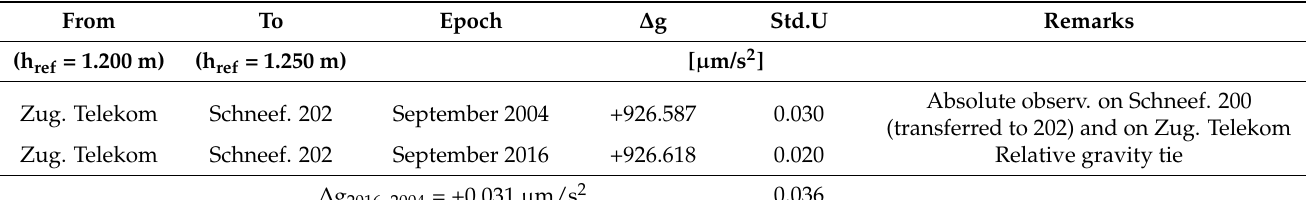
Table 5. Gravity differences between the two Zugspitze stations Telekom (summit) and Schneefernerhaus 202 ( ≈ 300 m below summit) measured in 2004 (absolute gravimetry and centring) and in 2016 (relative gravimetry). From To Epoch ∆ g